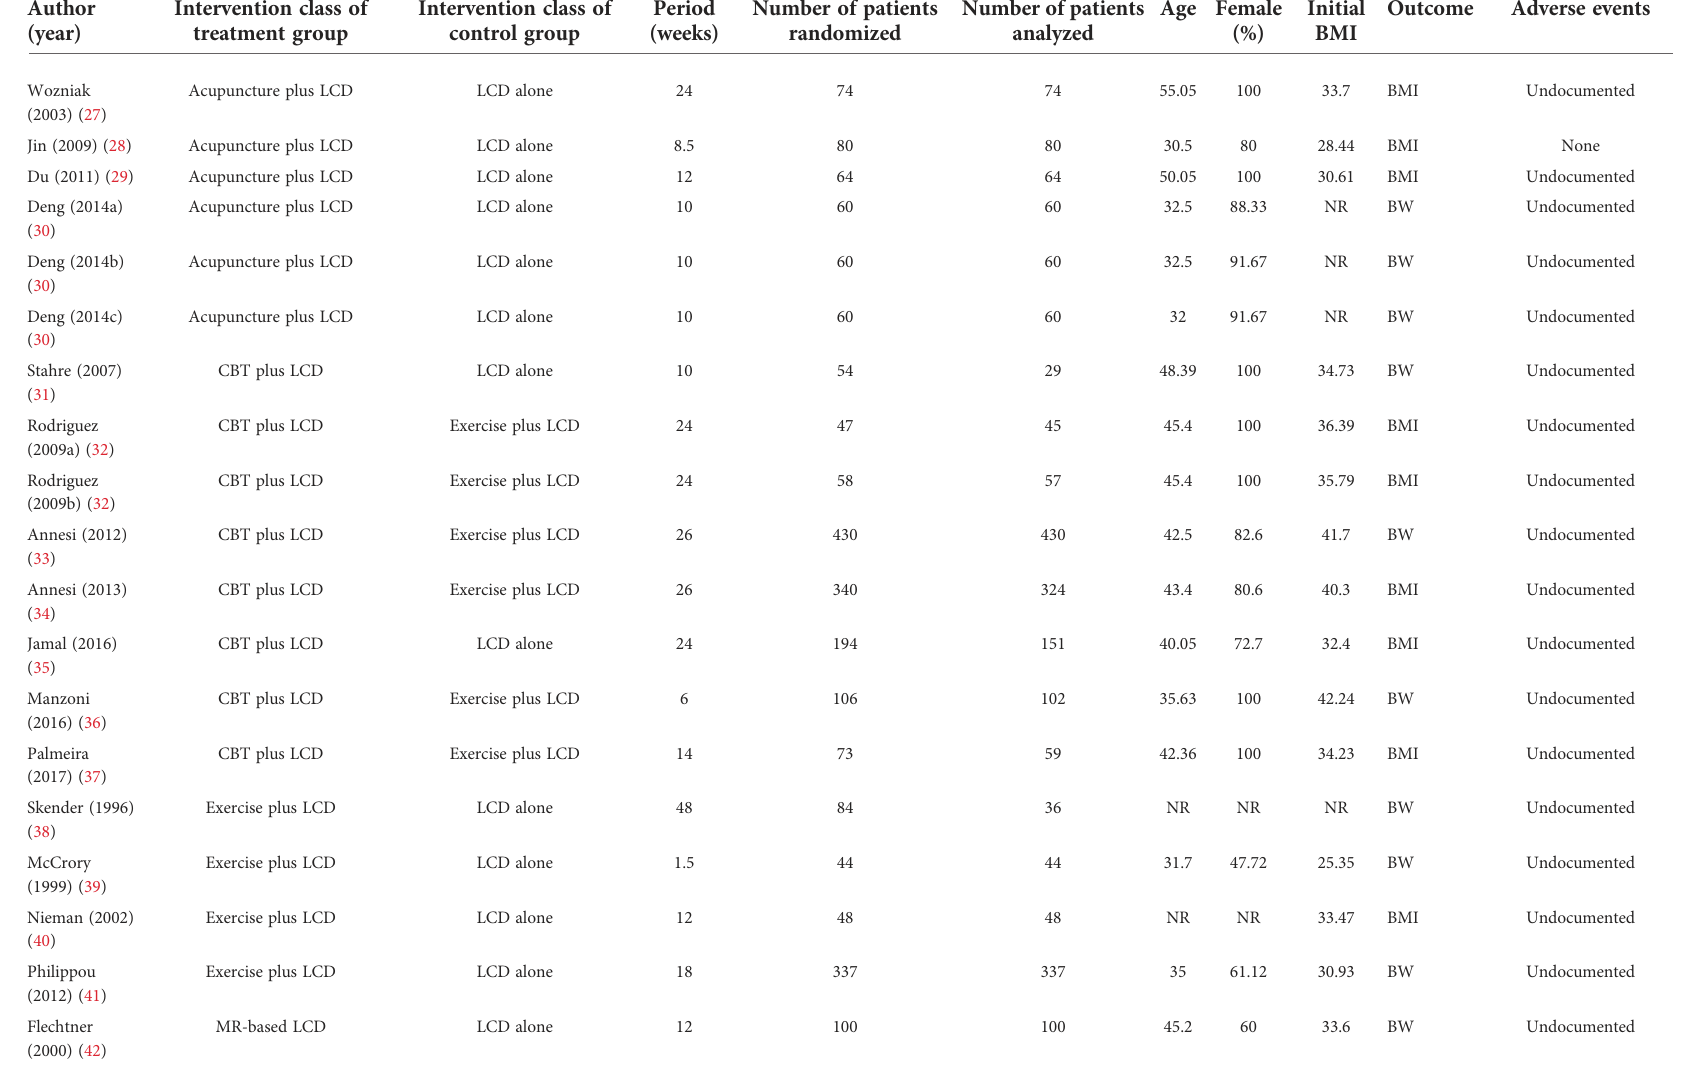
TABLE 1 Characteristics of the included randomized controlled